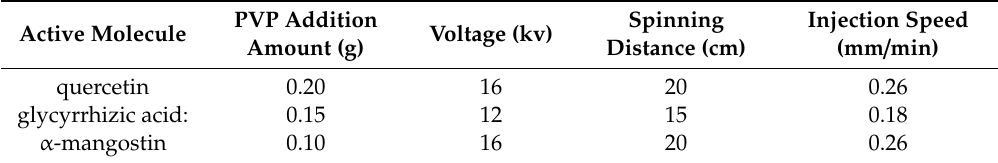
Table 6. The optimal spinning conditions for three active molecules.